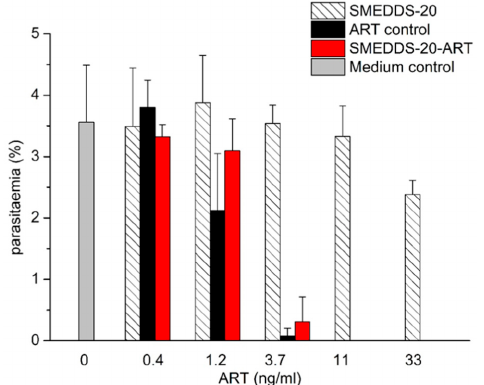
Figure 6. In vitro efficacy of free artemisone and SMEDDS-20-ART on P. falciparum in culture. Parasitaemia at time point zero was about 1%.